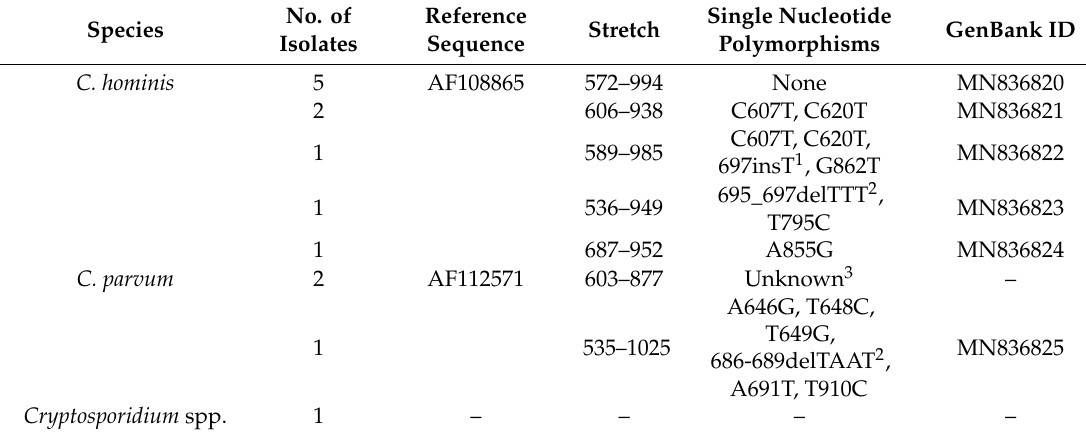
Table 4. Diversity, frequency, and molecular features of Cryptosporidium spp. sequences at the ssu rRNA locus obtained in the children population under study in Legan é s, Madrid, 2017–2019. GenBank accession numbers are provided. No. of Reference Species Isolates Sequence